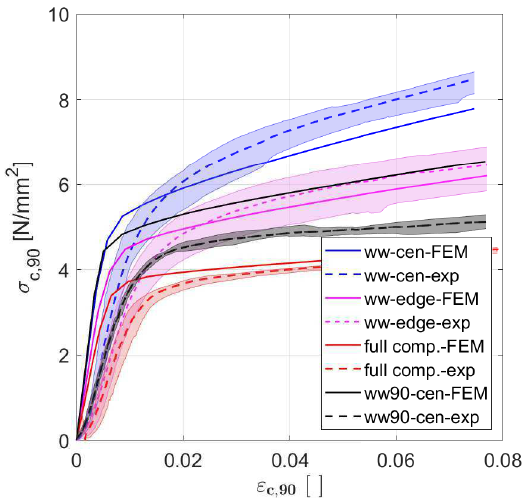
Figure 5. Compression stress vs. strain curves for center and edge positions of walls in series W80-F140 for ( a ) wood-to-wood contact ( ww ), ( b ) screw ( screw ), and ( c ) acoustic ( acoustic ) connections.